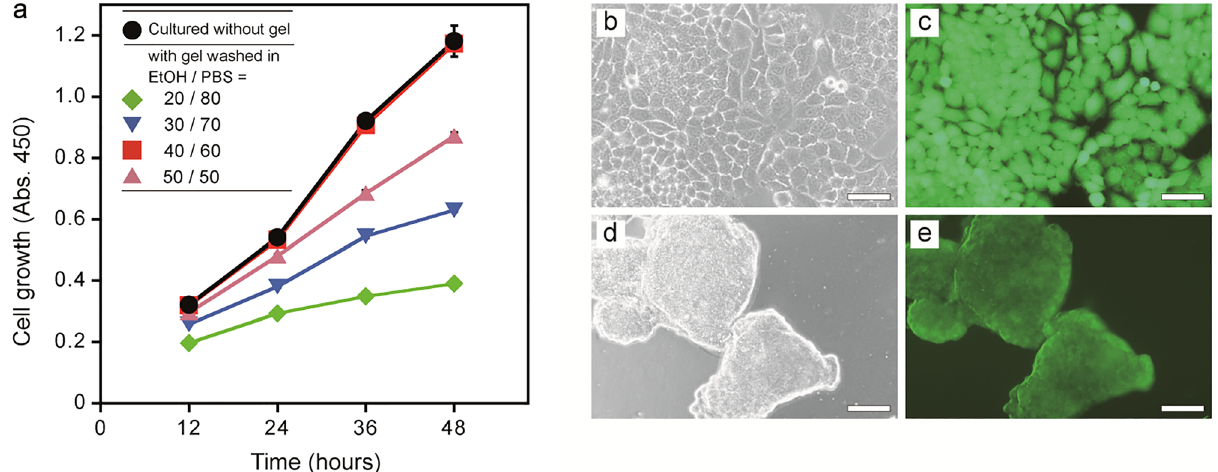
Figure 6. Biocompatibility of PC(PEW-C 12 E 5 )-gel and cell cultivation on the gel. ( a ) Growth of HL-60 cells in the presence of PC(PEW-C 12 E 5 ) gels washed in ethanol and PBS the mixture. Washing with a 40/60 ethanol/ PBS ratio (red filled square) showed normal cell growth equal to positive control group (cultured without gel, black filled circle). Error bars indicate S.D. ( b – e ) Growth of standard dish-cultured NCI-H460 cells ( b , c ) and on